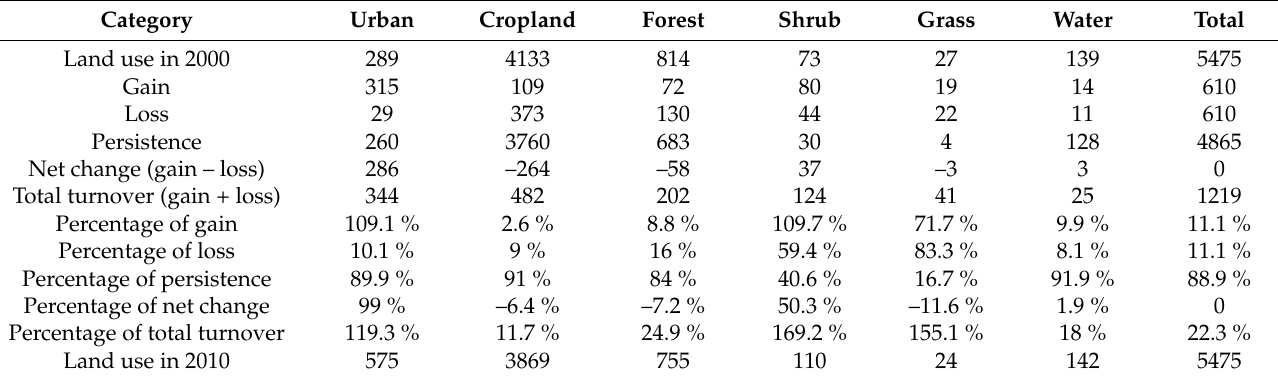
Figure 4. LULC classification images of 2000, 2010, and 2015. Table 3. Land accounts of Chongqing capital from 2000 to 2010 (unit: km 2